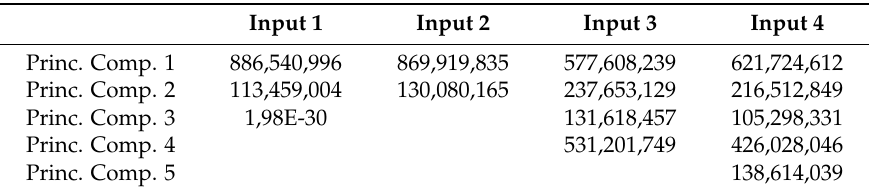
Table 3. Principal Component Analysis (PCA) results: total variance explained for Input 1, Input 2, Input 3 and Input 4 sets.